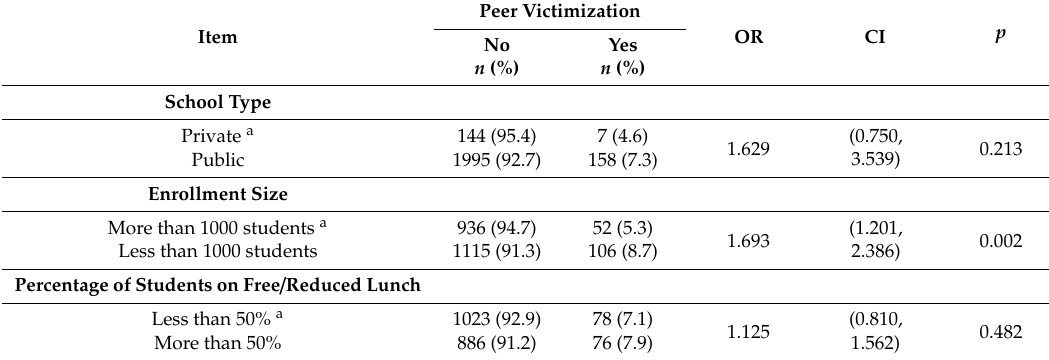
Table 2. School Characteristics and Peer